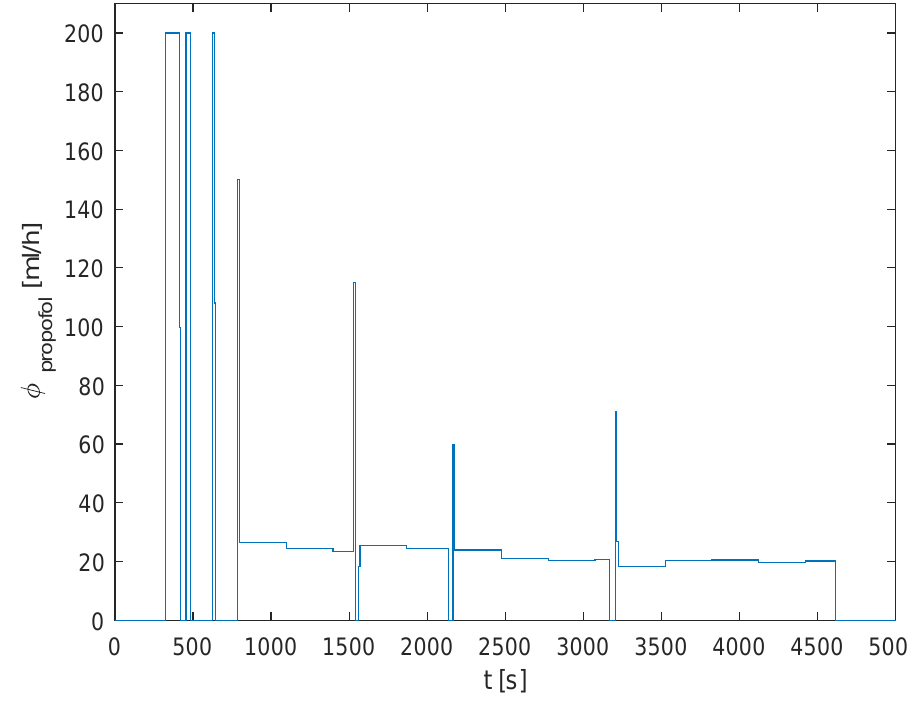
Figure 2. The inflow of propofol φ propofol .